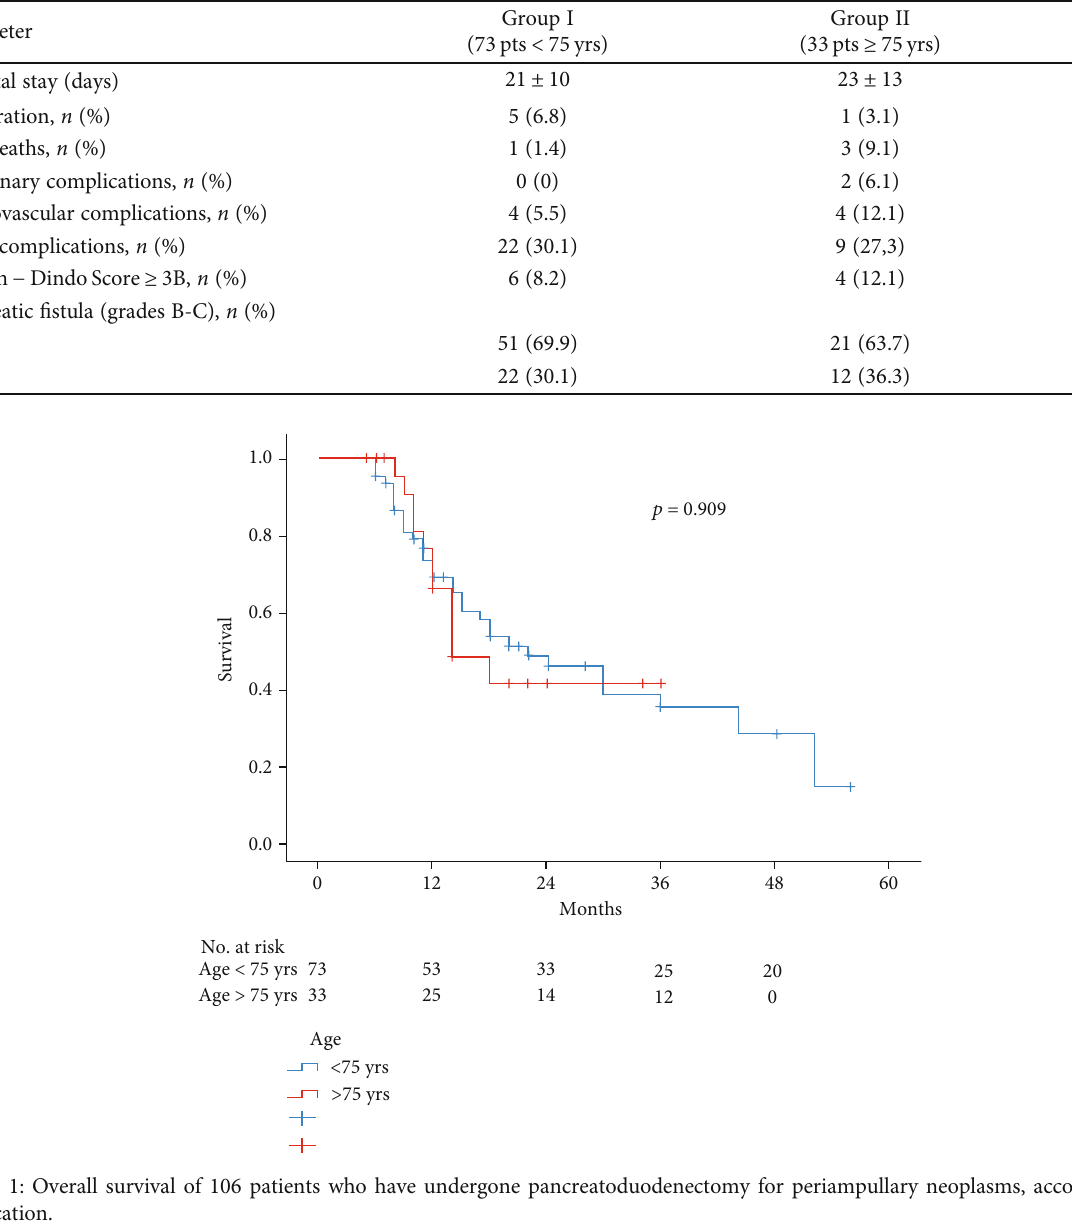
Table 3: Postoperative outcome of 106 patients who have undergone pancreatoduodenectomy for periampullary neoplasms.